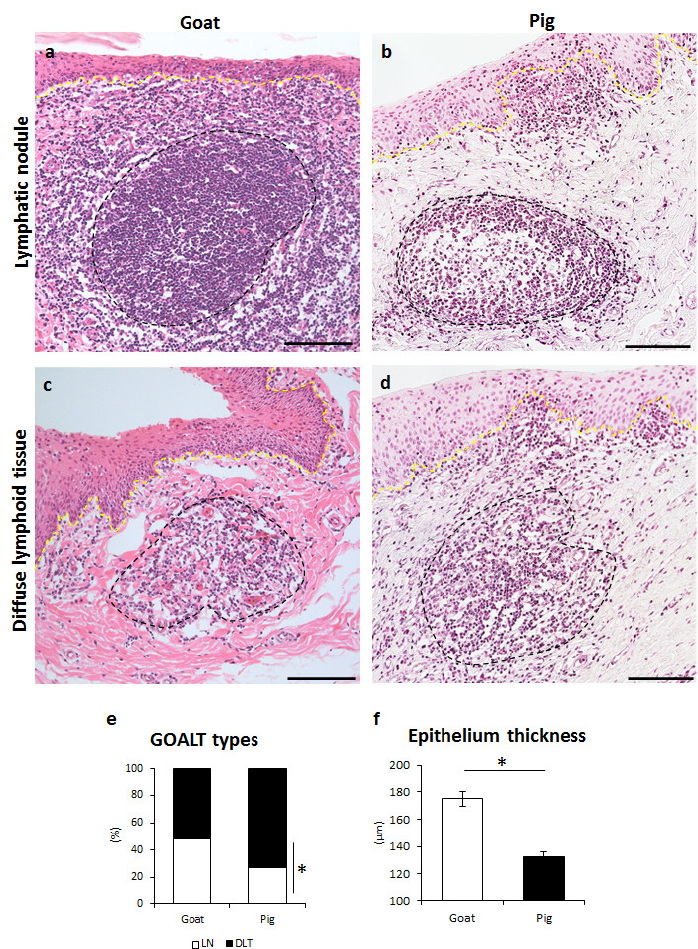
Figure 2. Histology of GOALTs found in the goat and pig VV. ( a ) Goat LN localizes in the LP while partially disrupting the structure of the epithelium of VV. ( b ) Pig LN localizes in the LP of VV, entirely neighbored by connective tissues. ( c , d ) Goat and pig DLT localizes in LP of VV not disrupting epithelium. Diffusely distributed lymphocytes are shown between DLT and epithelium. Black dotted line shows the approximate boundary of GOALTs. Yellow dotted line indicates basement membrane. H&E staining. Scale bars = 100 µ m. ( e ) Appearance of the percentage of LNs and DLTs in the examined GOALTs of the VV. n ≥ 5. ( f ) Epithelium thickness of VV. Values = mean ± SE. n ≥ 5. Significant difference between the goat and pig is indicated by * p < 0.05; Mann–Whitney U